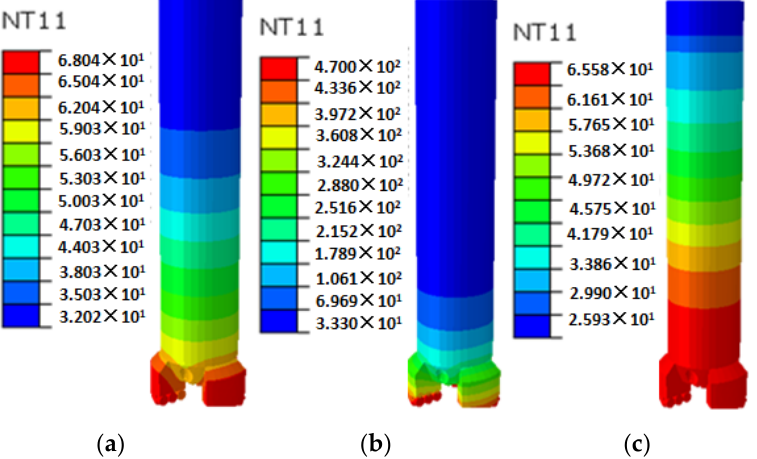
Figure 19. Temperature nephogram of the core bit and core tube at core depth of 100 m in ZG: ( a ) the end of first stage; ( b ) the end of second stage; ( c ) the end of third stage.